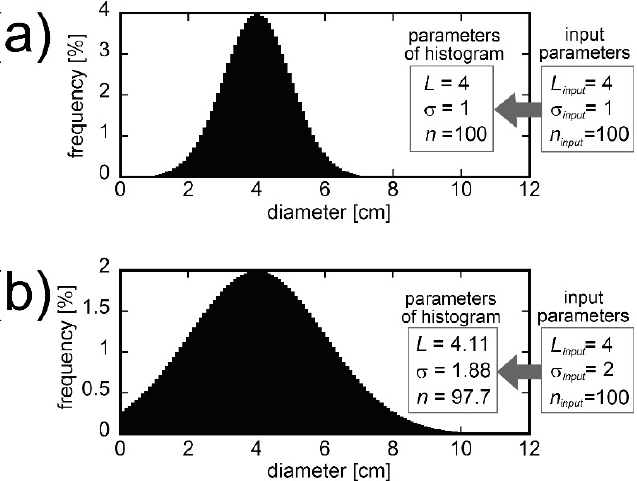
Figure 5. Examples of hypothetical histograms. Large L input and small σ input values result in the same outputs of L and σ as shown in ( a ). That is, the statistical parameters of histograms are unchanged. However, in the other cases, the input values are different from those of the histogram as shown in ( b ) because a portion of the smaller size class is eliminated.